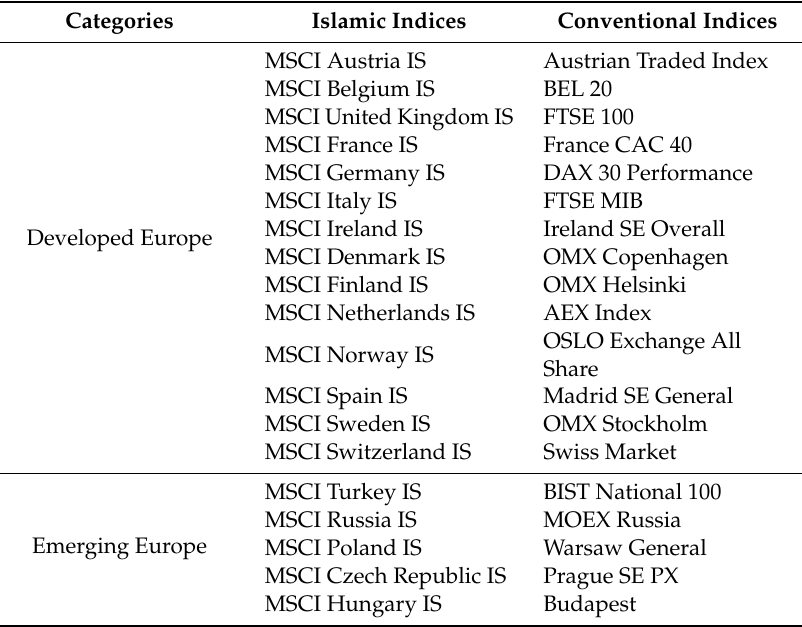
Table 2. European Region’s Islamic and Conventional Stock Indices.